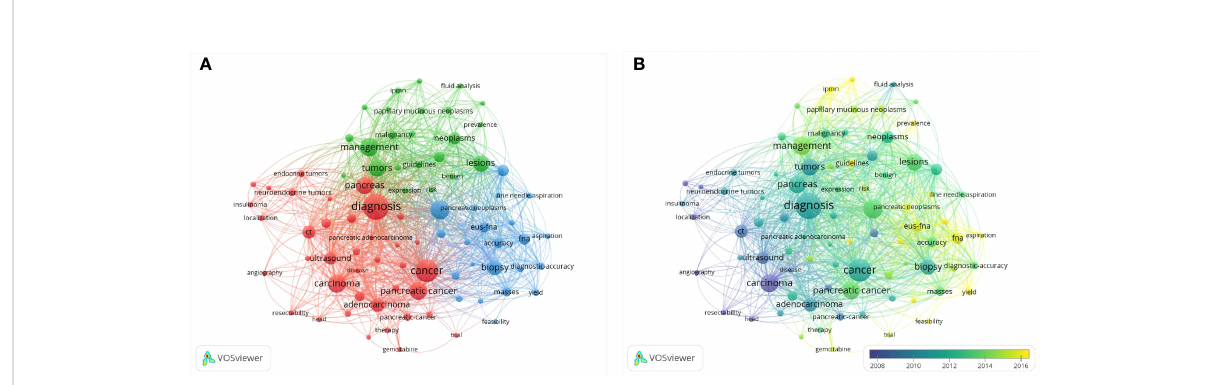
FIGURE 8 Co-occurrence analysis of keywords. (A) Network visualization map of keywords, (B) Overlay visualization map of keywords.